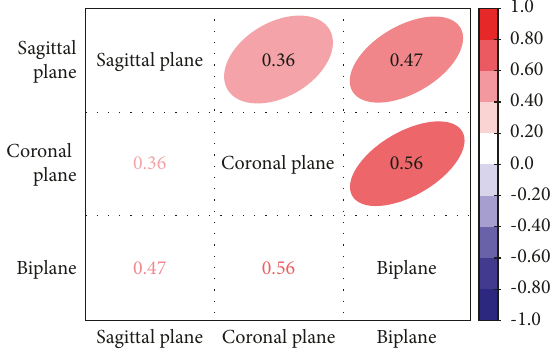
Figure 9: Correlation heatmap between evaluation methods. ∗ Positive correlations are represented in red, and negative corre- lations are represented in blue. Stronger correlations are repre- sented by darker